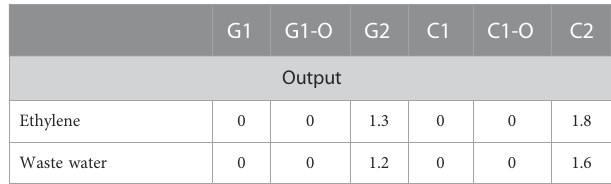
TABLE 5 Scenario mass balances in